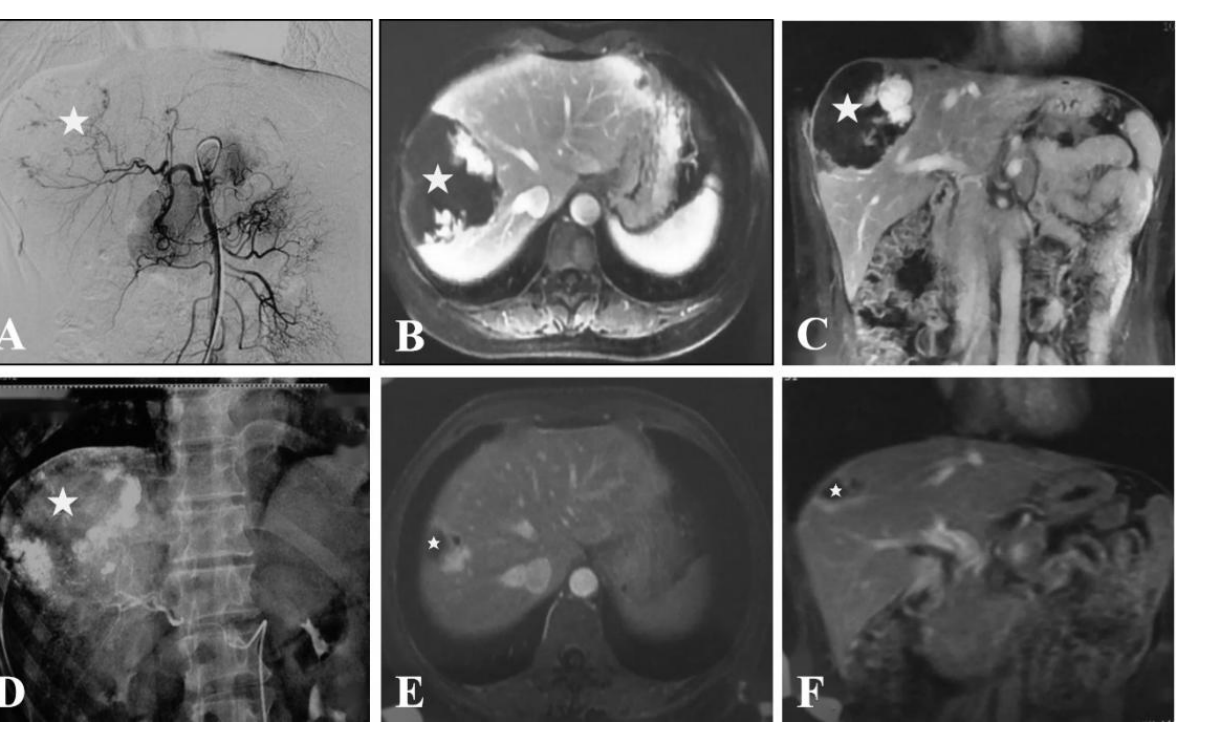
Figure 1. Representative case of significantly reduced tumor with transarterial arterial emboliza- tion (TAE) using Lipiodol–Bleomycin emulsion (LBE). A 41-year-old woman presented with right upper quadrant discomfort and the diagnosis of the hemangiomas was made using magnetic res- onance imaging (MRI). She was followed up for 5 years after TAE. ( A ). Digital subtraction angi- ography (DSA) of the hepatic artery, arising from the supper mesentric artery, showed a large hy- pervascular mass ( ★ ) in the right lobe of the liver. ( B ). Axial contrast-enhanced T1-weighted MRI obtained before TAE showed a large hypervascular lesion in the right lobe of the liver ( ★ ). ( C ). Coronal contrast-enhanced T1-weighted MRI obtained before TAE showed a large hypervascular lesion in the right lobe of the liver ( ★ ). ( D ). Upper abdominal radiogram obtained immediately post-TAE with LBE demonstrated the high dense lipiodol-emulsion retention in the lesion ( ★ ). ( E ). Axial contrast-enhanced T1-weighted MRI obtained at 5 years post-TAE showed a small residual lesion ( ★ ). ( F ). Coronal contrast-enhanced T1-weighted MRI obtained at 5 years post-TAE showed a small residual lesion ( ★ ) with a 95% reduction of the hemangioma. This patient had complete resolution of her abdominal symptoms at 3 months after TAE.